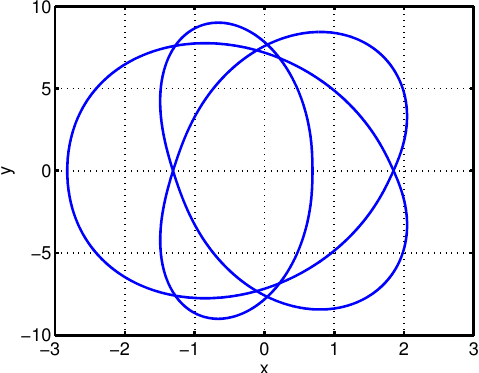
Fig. 3 Periodic orbit located at x = 0 . 69, T = 165 for C = 1 . 92, and µ = 0 .